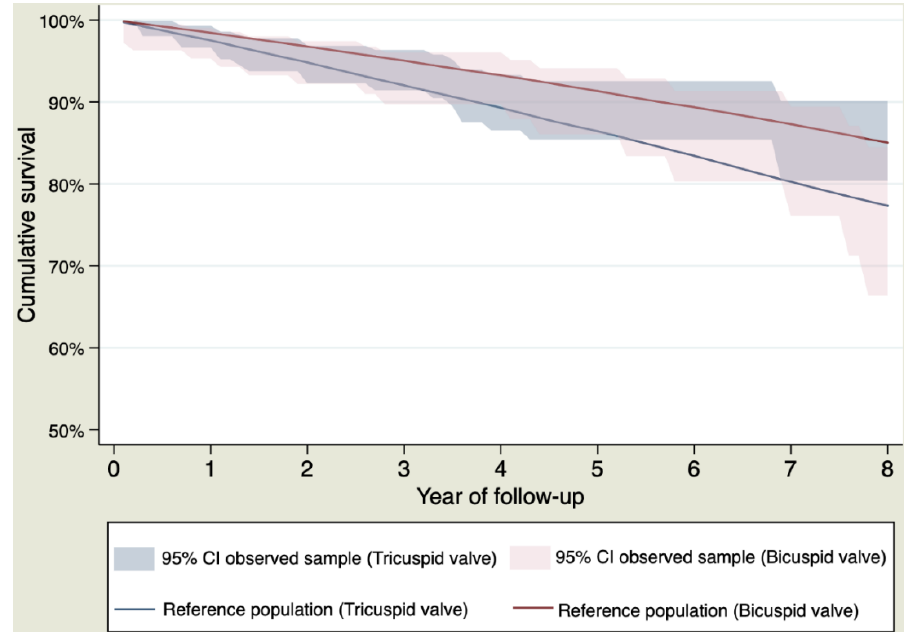
Figure 4. Survival curves stratified by bicuspid or tricuspid aortic valve for patients who survived the postoperative period.